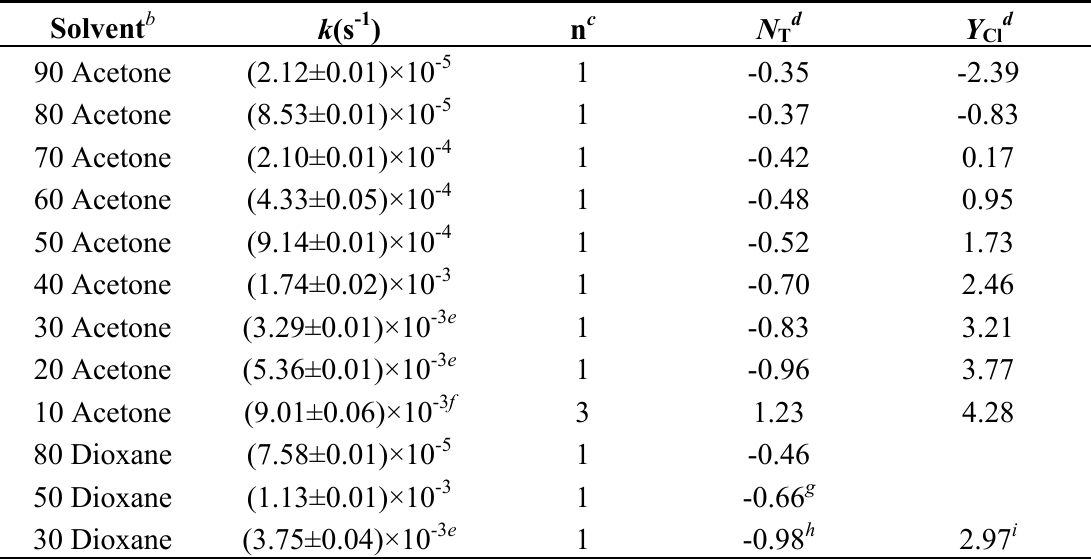
Table 3 . Specific rates of solvolysis ( k ) of trans - β -styrenesulfonyl chloride ( 3 ) a in aqueous acetone and aqueous dioxane at 45.0 ºC.